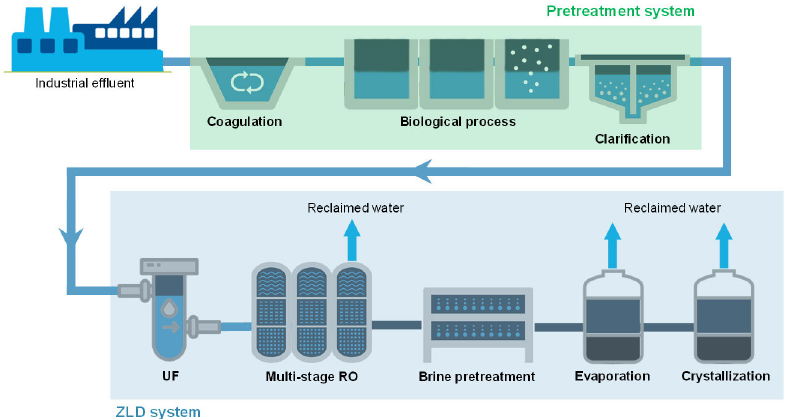
Figure 1. Typical processes to achieve zero liquid discharge (ZLD) in management of industrial